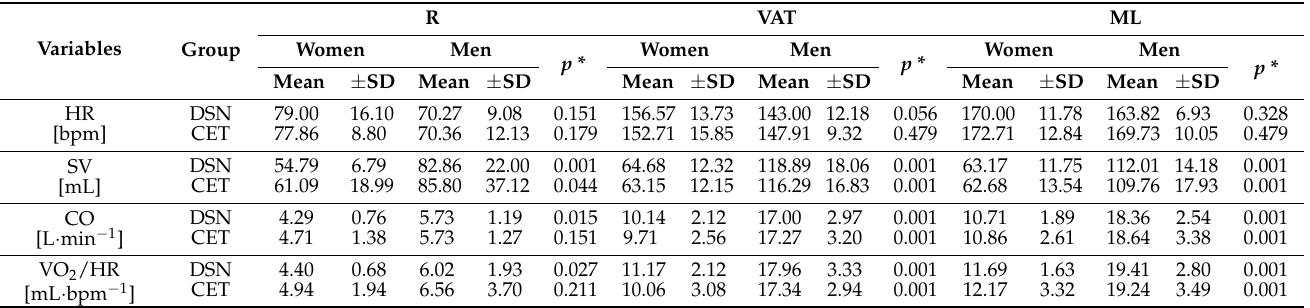
Table 5. Gender comparison of the cardiovascular values obtained during DSN and CET by women (n = 7) and men (n =